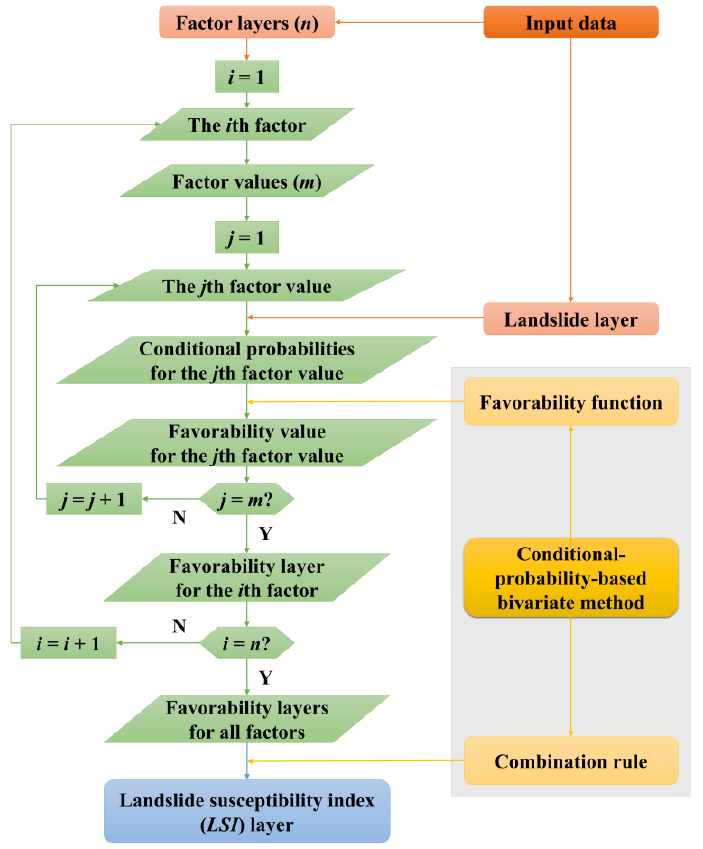
Figure 2. General steps of conditional-probability-based bivariate